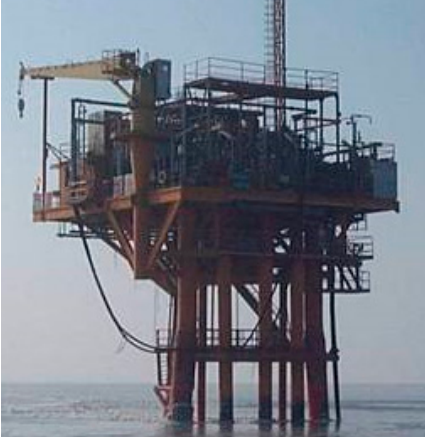
Figure 1. The natural gas platform where the accident took place.